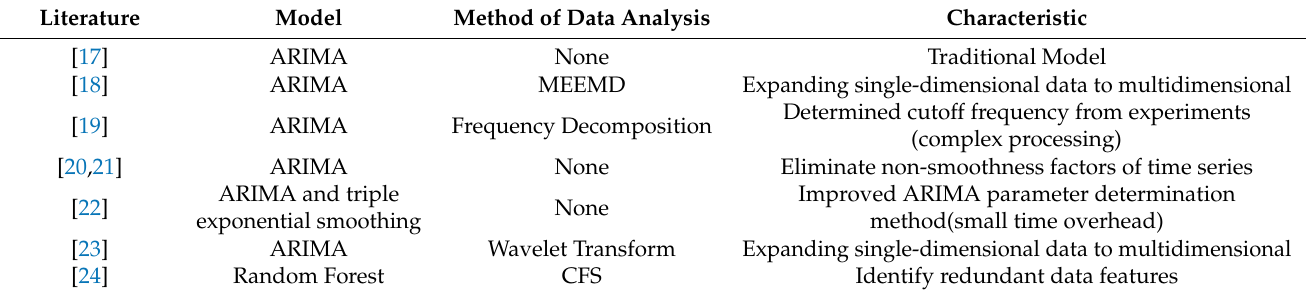
Table 1. Characteristics of